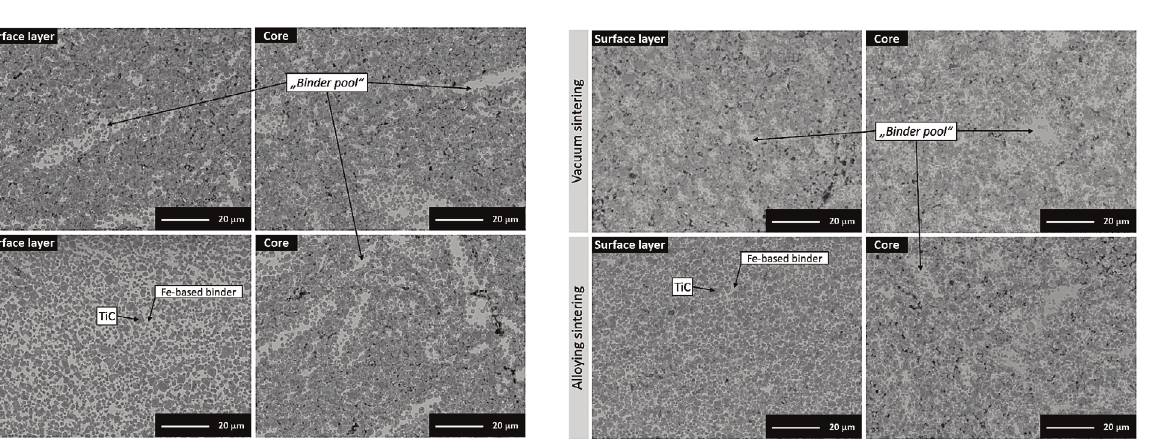
Fig. 4. The SEM images of microstructures of TiC-FeCrMn cermet after vacuum sintering (top) and alloying sintering in Mn microatmosphere (bottom). Microstructures of the surface layer (left) and the core region (right) are